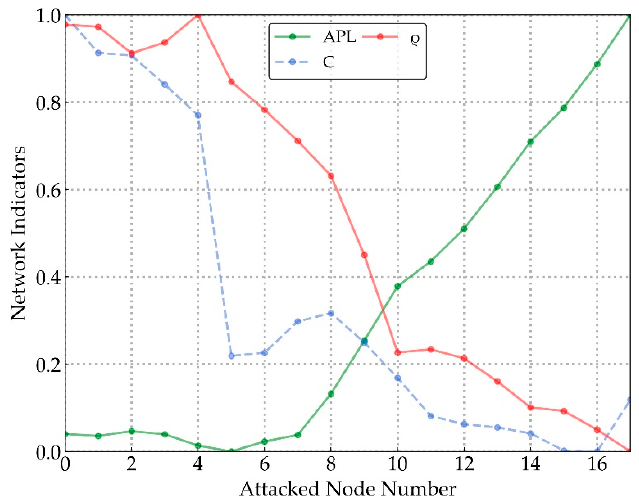
Figure 5. Number of edges of the attacked NQPB.